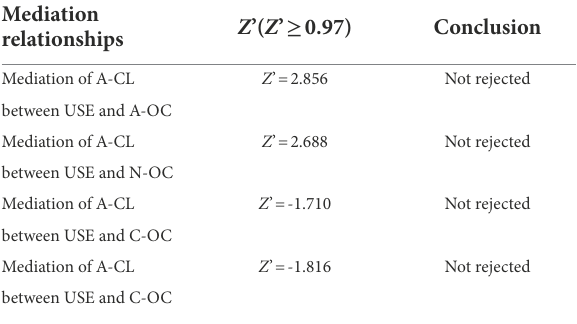
TABLE 4 Mediation relationships of affective commitment to the leader in the relation between employees’ emotional awareness and organizational